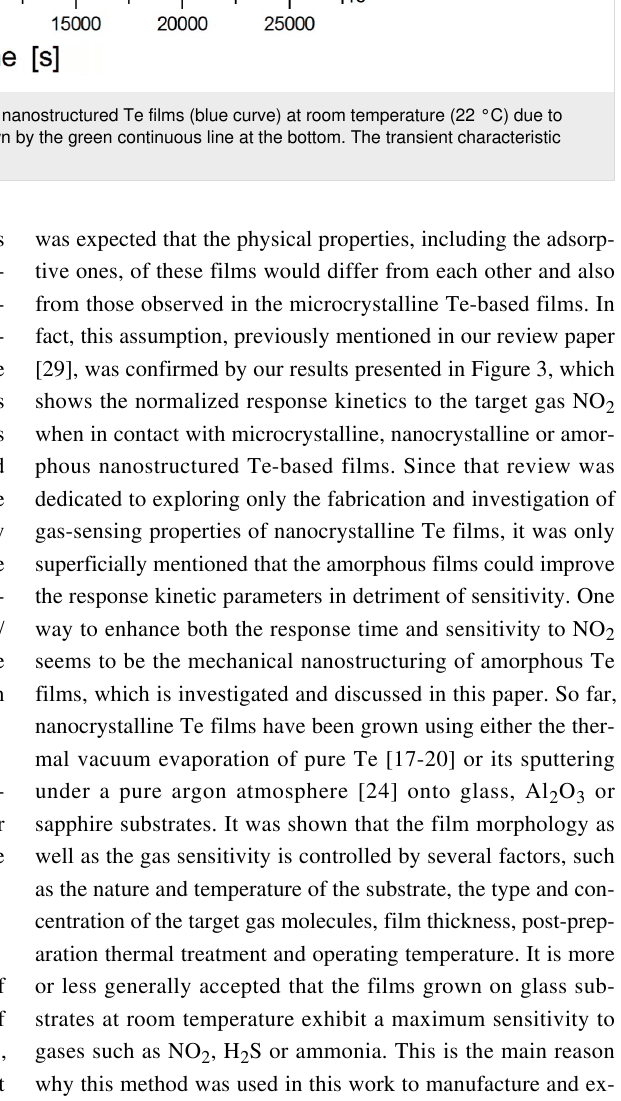
tured Al 2 O 3 substrate. The NO 2 exposure profile curve is shown by the green continuous line at the bottom. The